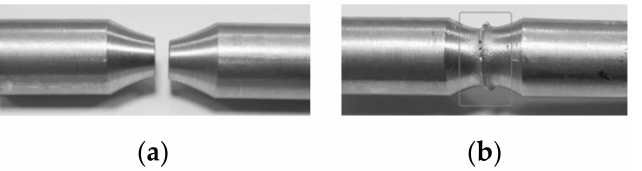
Figure 26. 6XXX series aluminium alloy sample: ( a ) before the friction welding process; ( b ) after the friction welding process.